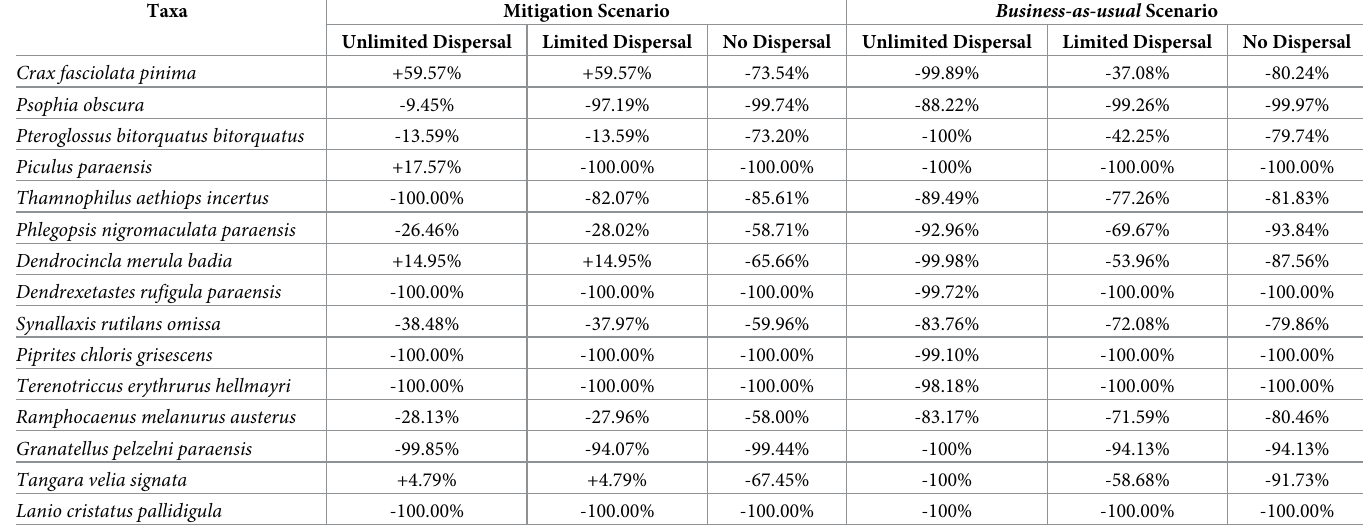
Table 2. Estimates of loss and gain of adequate areas in relation to climatic and deforestation impacts, considering the three dispersal frameworks. The mitigation scenario relates the optimistic climate projections (rcp45) to GOV’s predicted deforestation, whereas the Business-as-usual scenario relates the pessimistic climate (rcp85) to the BAU deforestation predictions. The numbers indicate the percentage of variation in the size of suitable areas in the future compared to currently suitable areas. Neg- ative values (—) indicate loss while positive values (+) indicate gains of suitable areas.